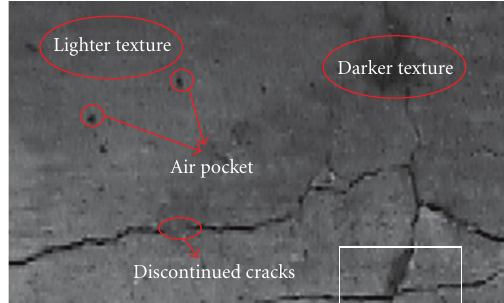
Figure 6: Example image taken from a concrete component in the field. Note the non-crack image artifacts annotated. The subregion in the bottom-right bounding box is used to illustrate the proposed level-set detection